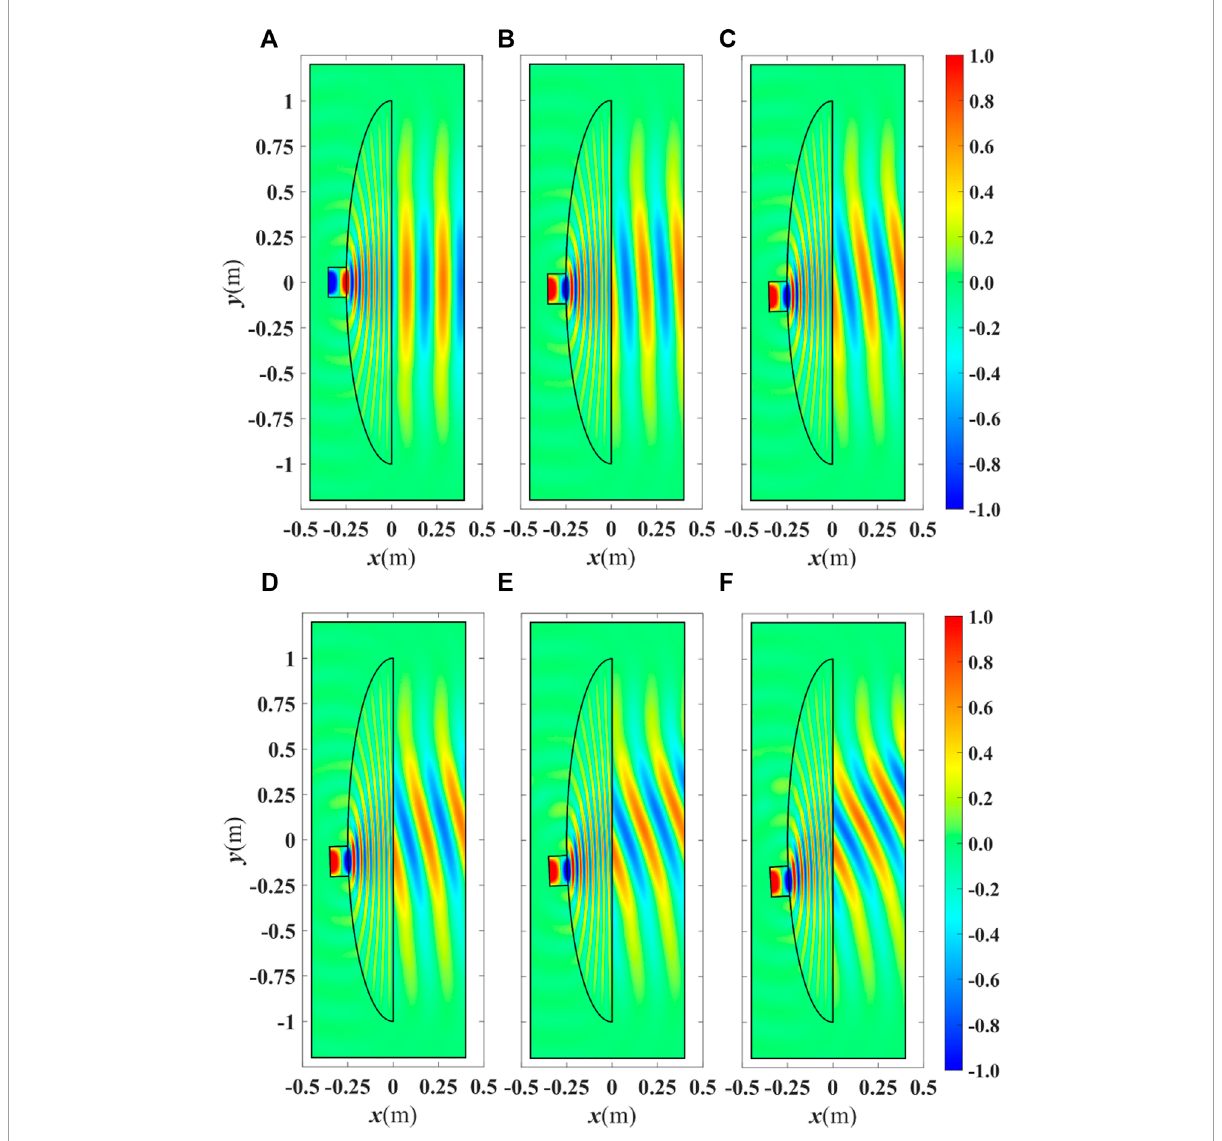
FIGURE 3 Real part of E z for the EHMFEL excited by a waveguide carrying the TE 1 mode at a frequency of 1.5 GHz for a beam direction θ of (A) 0°, (B) +4°, (C) +8°, (D) +12°, (E) +16°, and (F) +20°. The waveguide is moved across the elliptical boundary to achieve beam